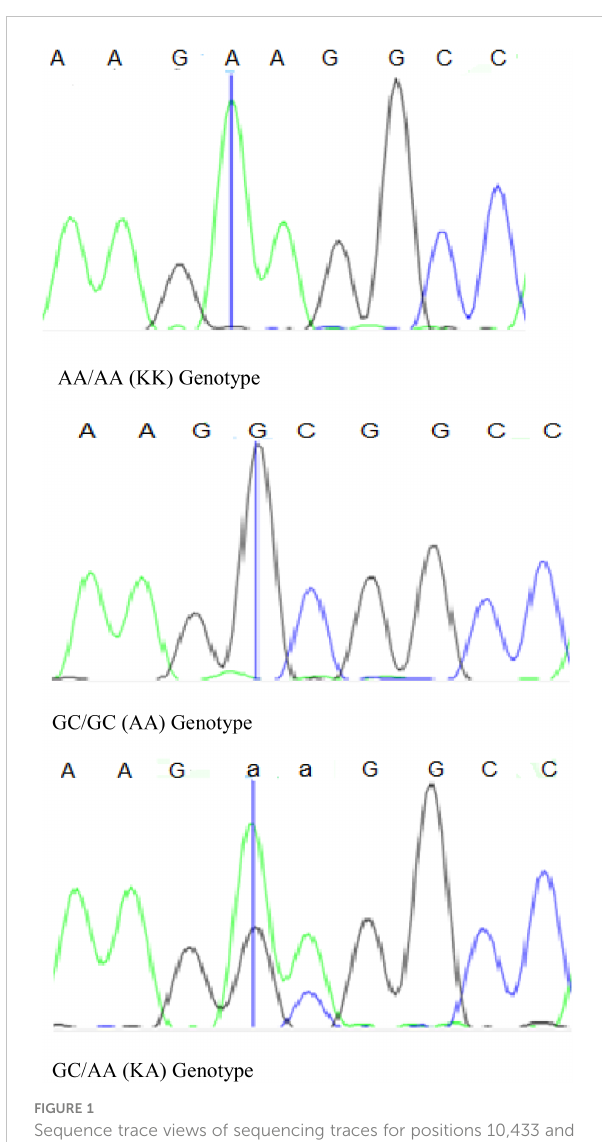
FIGURE 1 Sequence trace views of sequencing traces for positions 10,433 and 10,434. The vertical line indicates nucleotide position 10,433. Positions 10,433 and 10,434 are responsible for the K232A substitution. The positions of individual mutations were named according to the sequence available in GenBank